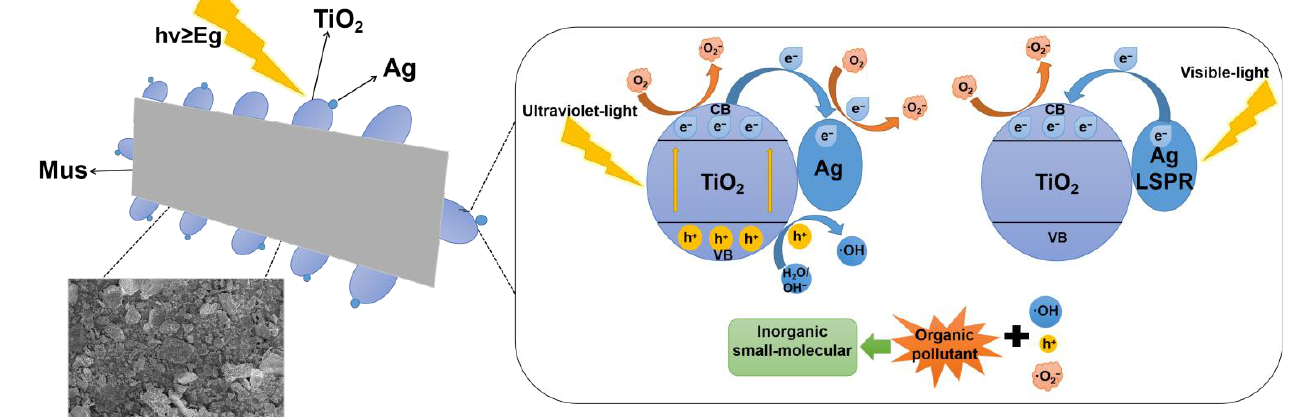
Figure 14. Schematic diagram of charge transfer and photodegradation of RhB for 1-ATM.